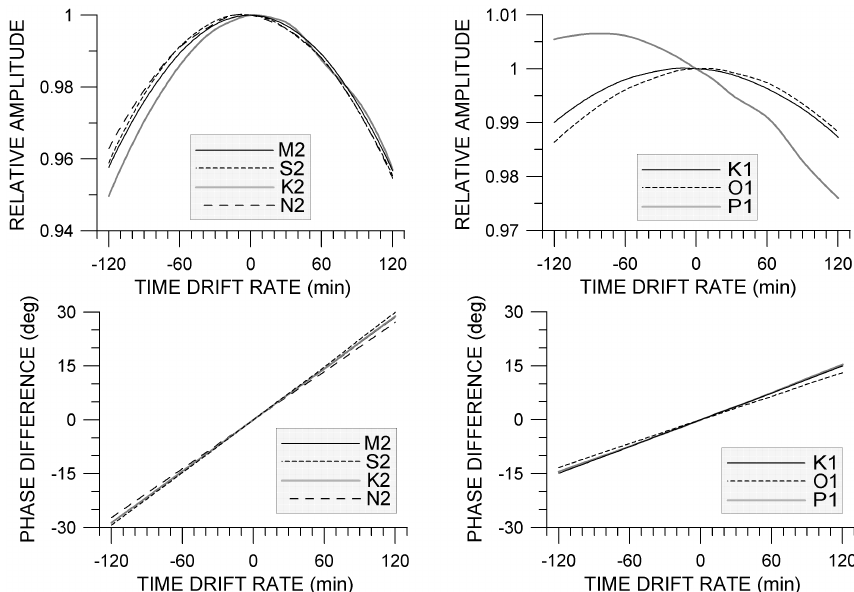
Fig. 7. Simulated changes in relative amplitudes and phase differences versus the time drift rate. The respective amplitude and phase are supposed to be 1 and 0 when no time drift was simulated.